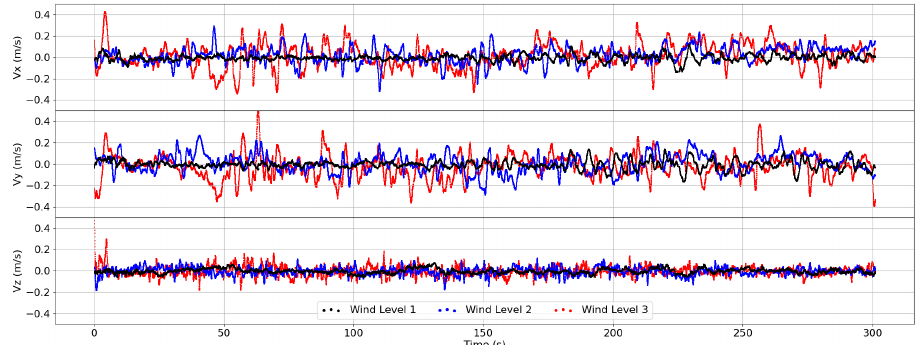
Figure 8. Comparison of DJI M600